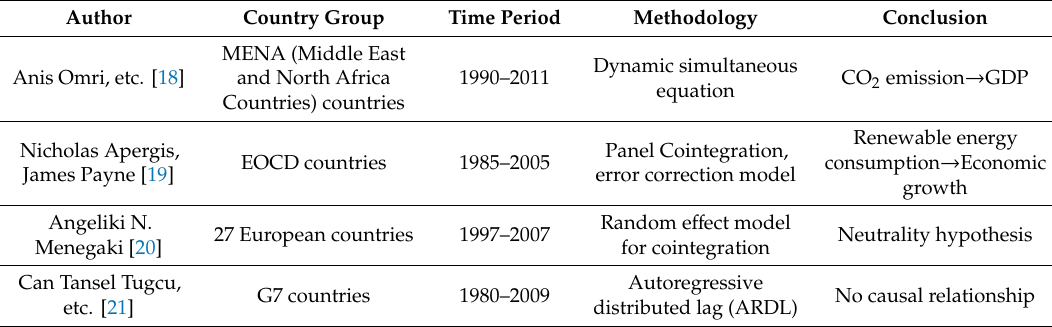
Table 2. Country groups case for Granger causality